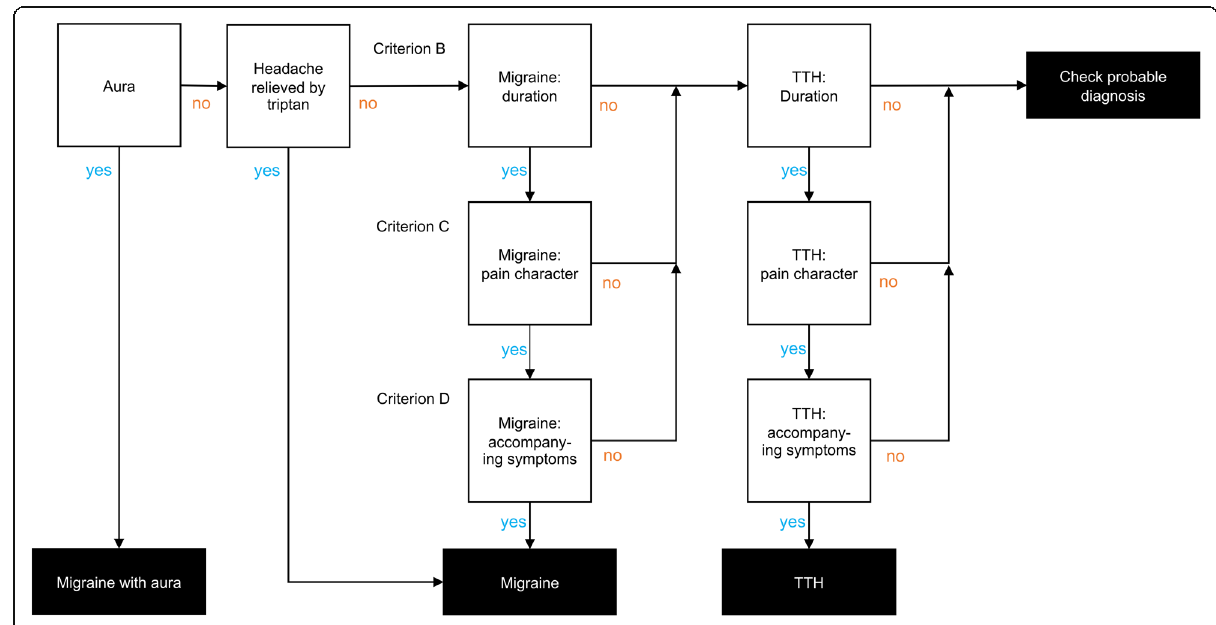
Fig. 1 Schematic structure of the